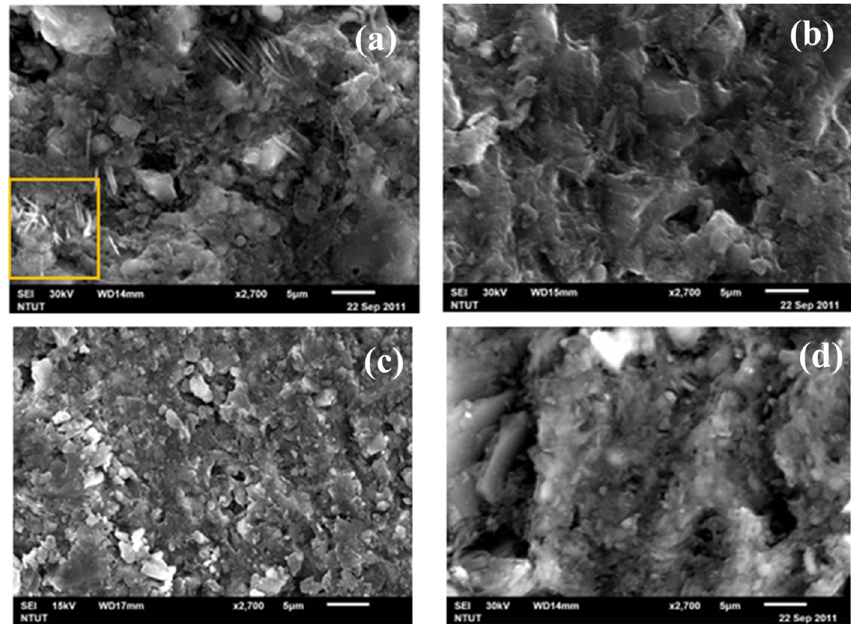
Figure 5. SEM images of build brick specimens made with geopolymer with various SiO 2 /Na 2 O molar ratios: (a) SiO 2 /Na 2 O = 0 ; (b) SiO 2 /Na 2 O = 1; (c) SiO 2 /Na 2 O = 2; (d) SiO 2 /Na 2 O = 3.7. molar ratios: ( a ) SiO 2 /Na 2 O = 0; ( b ) SiO 2 /Na 2 O = 1; ( c ) SiO 2 /Na 2 O = 2; ( d ) SiO 2 /Na 2 O =